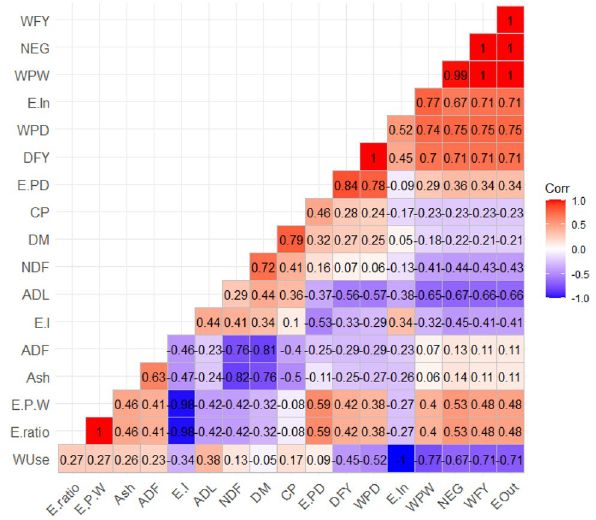
Fig. 5 Correlation plot for measuring association between meas- ured traits of maize 60% under full irrigation. WUse: water use, E.ratio: energy ratio, E.PW.: energy productivity of wet forage yield, ADF: cell wall hemicellulose free, E.I: energy intensity, ADL: lignin, NDF: neutral detergent fiber, DM: dry matter, CP: crude protein, E.P.D: energy productivity of dried fodder yield, DFY: dried fodder yield, W.P.D: wet forage yield, E.In: input energy, WP.W: water pro- ductivity of wet forage, N.E.G: net energy gain, WFY: wet forage yield, E.Out: output